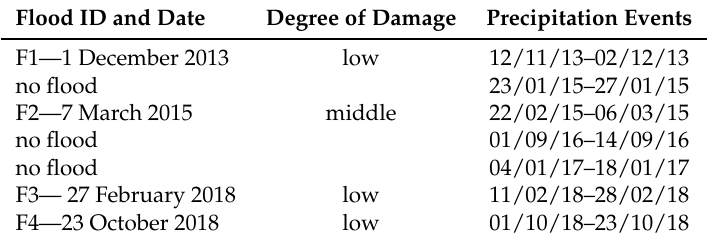
Table 1. Floods F1–F4, relative degrees of damage in the lowest course of the torrent and main precipitation events anticipating or not anticipating the